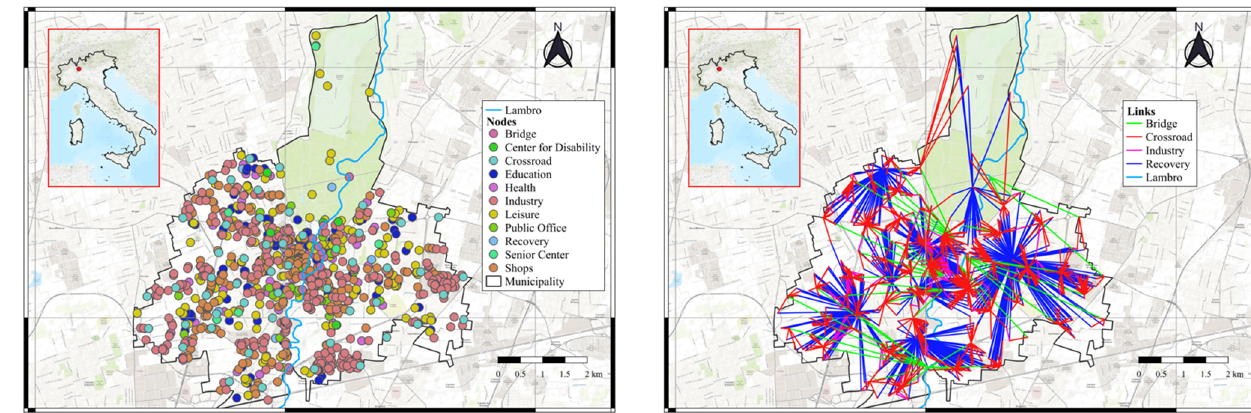
Figure 5. Map of providers ( left ) and services ( right ) exchange between themselves (case: no redundancy, the connections and providers to residential receivers were removed for readability).